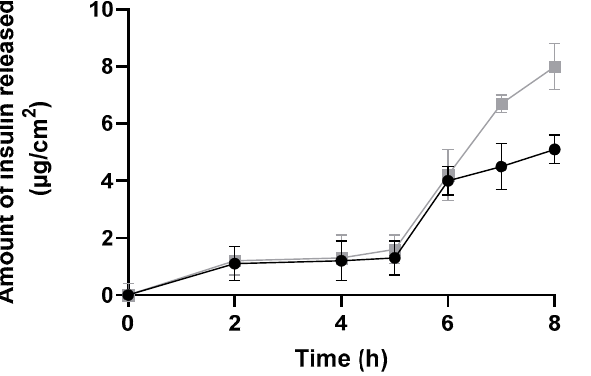
Figure 9. In vitro release profile through a silicone membrane from insulin-loaded NPs (black line), and a commercial solution of free insulin (grey line) over 8 h expressed in µg/cm 2 (mean ± SD, n = 6).